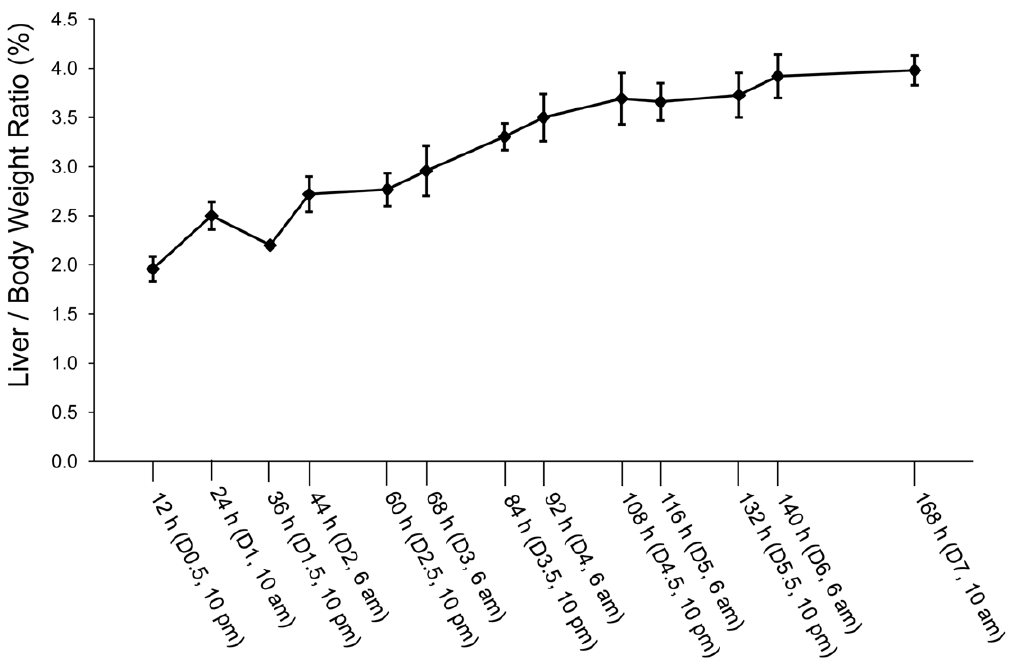
Figure 1. Liver regrowth following partial hepatectomy (PH). Mice were subjected to PH and sacrificed at the indicated time points. Liver and body weights were recorded. Liver-to-body weight ratio was used as a liver regrowth index. The results are presented as mean liver-to-body weight ratios 6 SD (n=3 mice per time point).